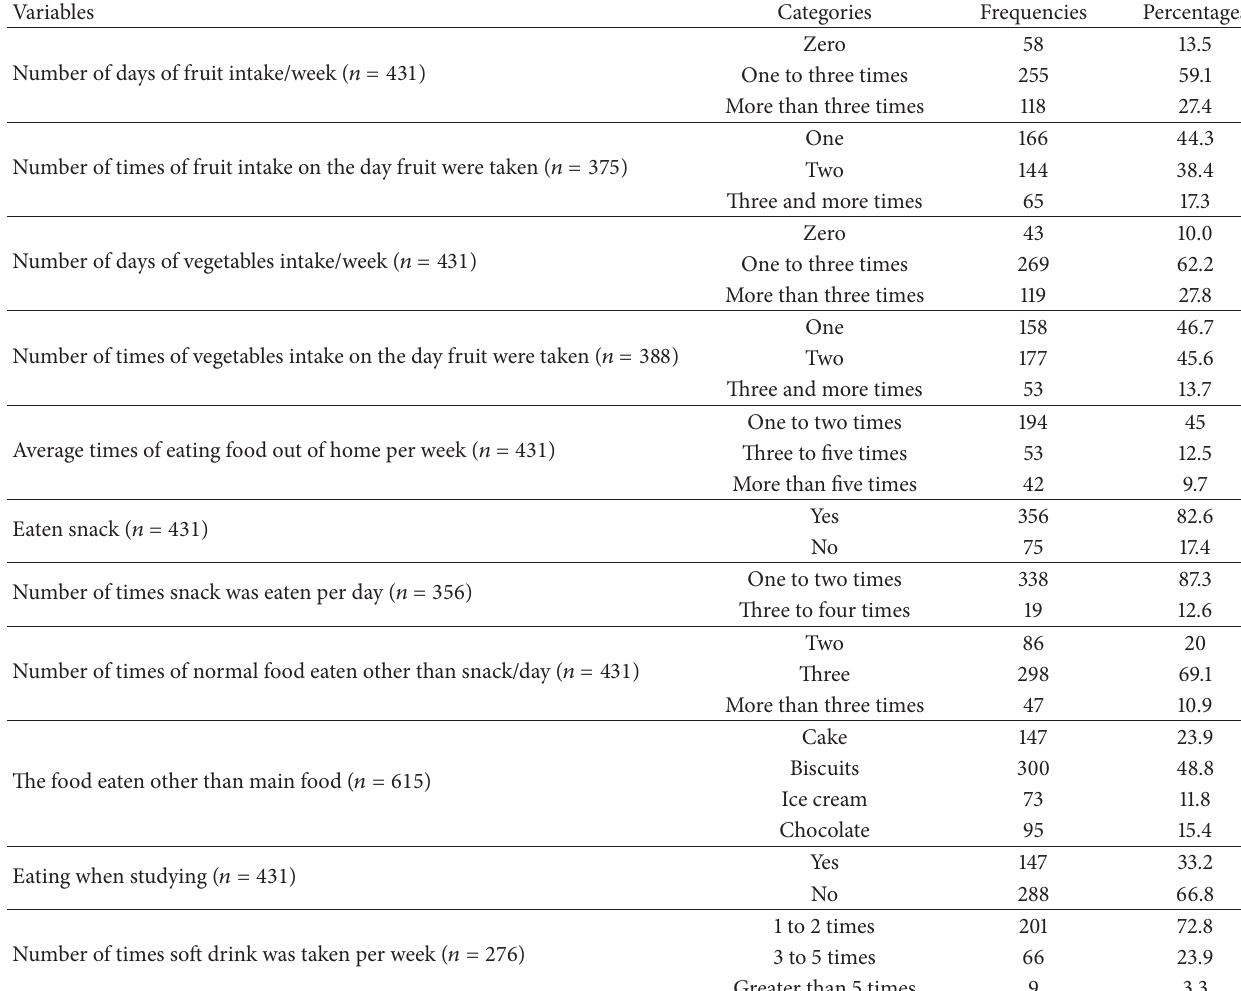
Table 2: Eating habits of high school students in Bahir Dar city, North West Ethiopia,